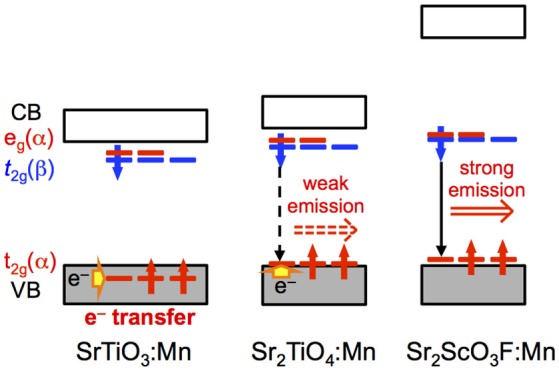
Proposed mechanism for SrTiO3:Mn, Sr2TiO4:Mn, and Sr2ScO3F:Mn.